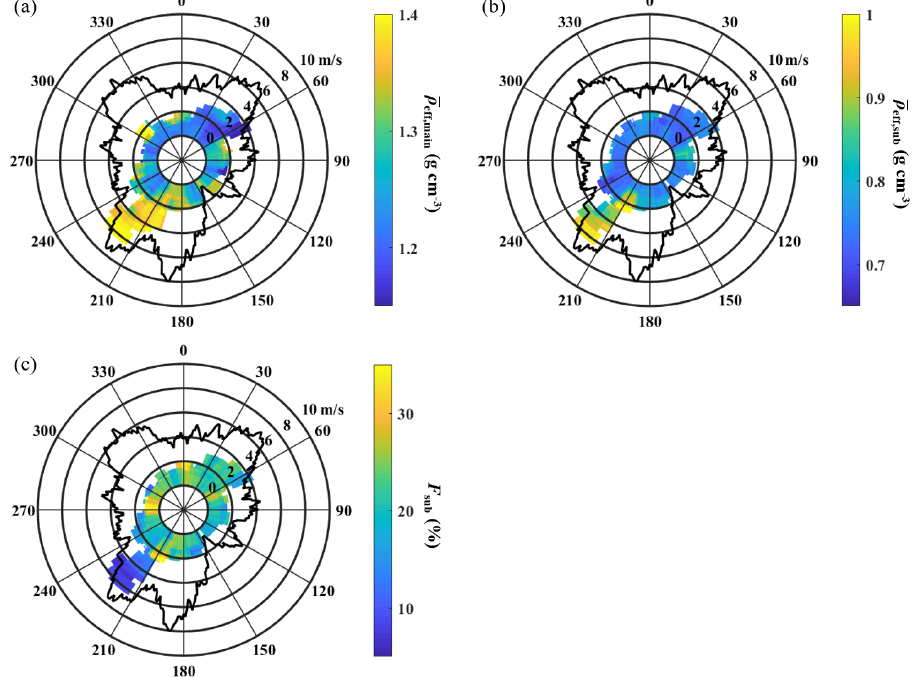
Figure 3. Wind rose analysis of (a) geometric mean of the main density mode ( ρ eff , main ), (b) geometric mean of the sub-density mode ( ρ eff , sub ), and (c) number fraction of the sub-density mode ( F sub ) for 150nm particles. Bold black lines represent the wind frequency during the entire sampling